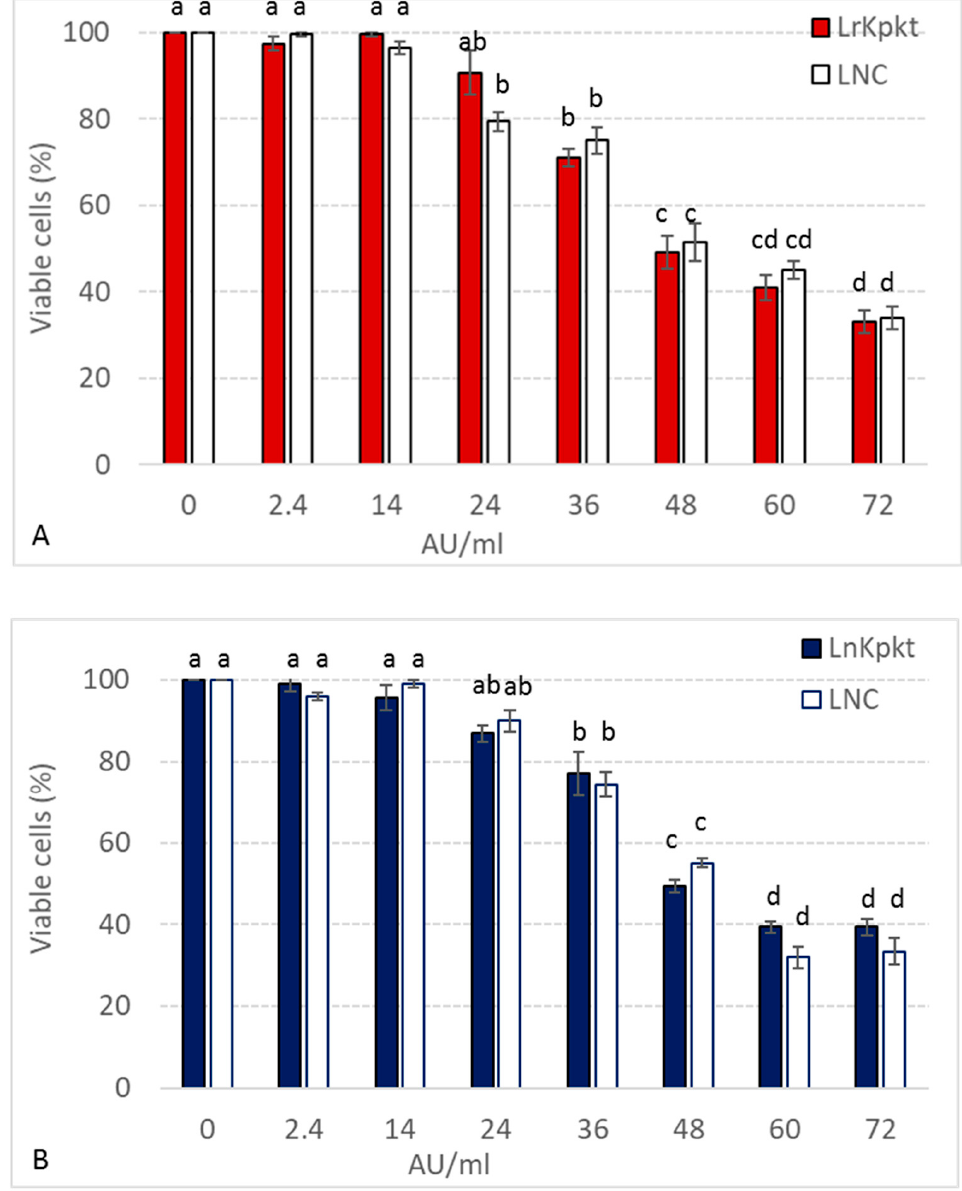
Figure 4. Viability of HaCaT cells after 24 h exposure to increasing concentrations of LrKpkt (A) and LnKpkt (B). Cell viability was determined in respect to positive controls (0 AU of LrKpkt or LnKpkt). LNC negative controls of killer activity. Results are means ± standard deviation of at least three independent experiments. Same superscript letters indicate results not significantly different ( p < 0.05).